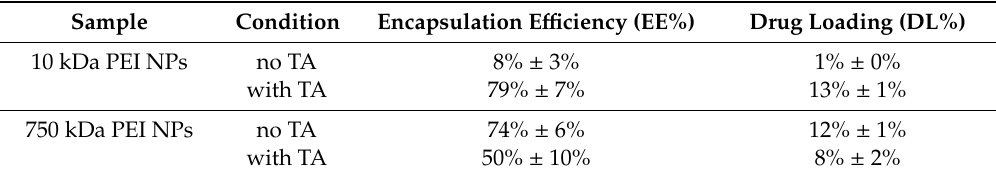
Table 4. E ff ect of tannic acid (TA) on protein